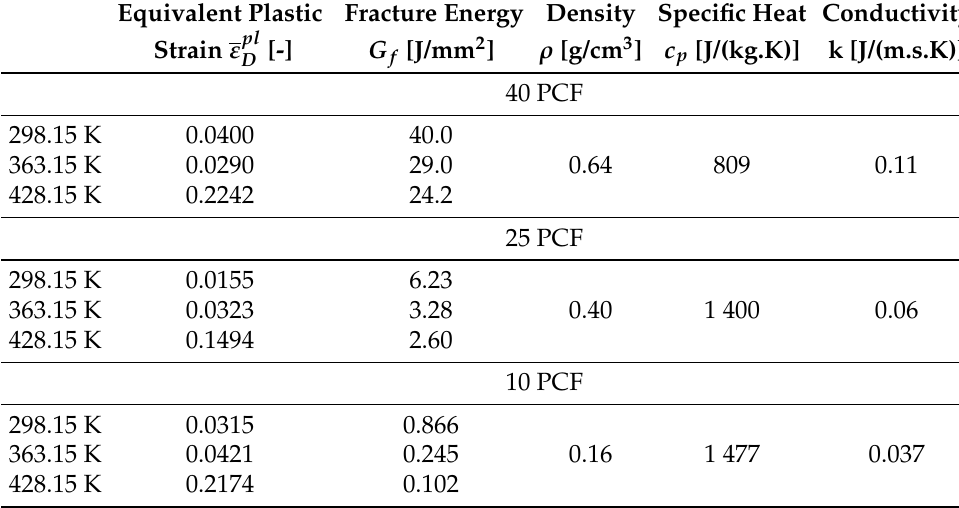
Table 1. Material parameters of all PUR foams dependent on temperature.